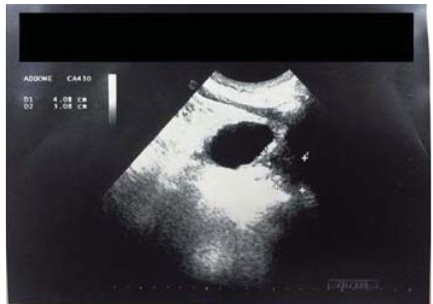
Figure 1: Ultrasound aspects of the renal hematoma.